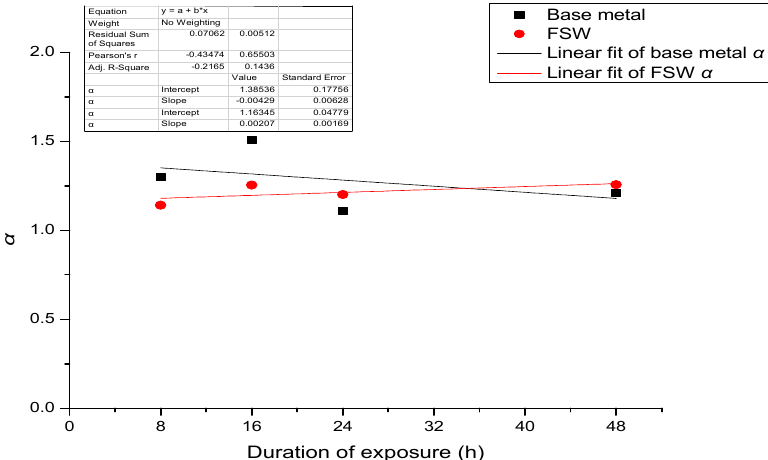
Figure 13. Variation of maximum depth due to corrosion-induced damage with duration of exposure to the environment at an applied stress ( σ ) of 0 MPa.